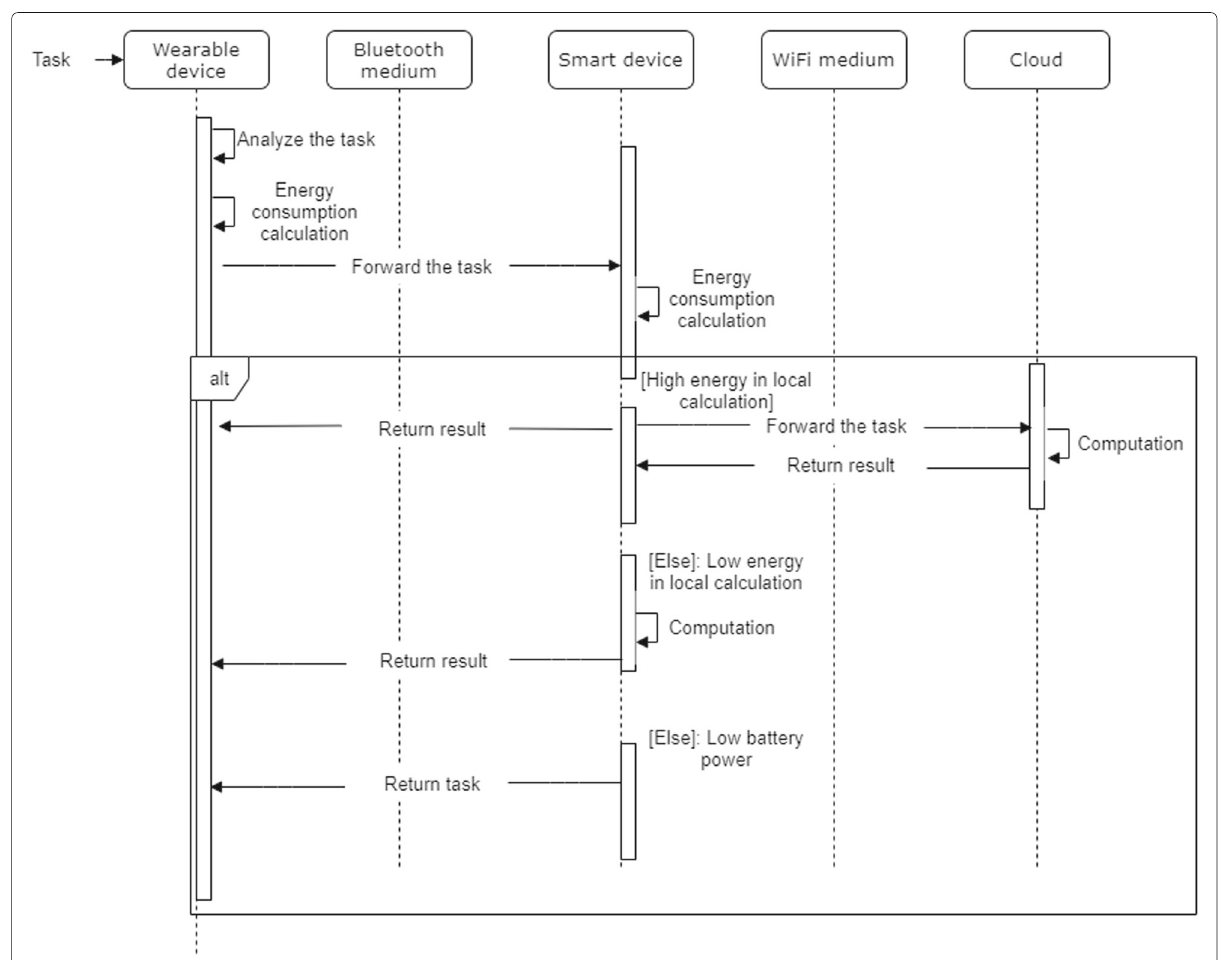
Fig. 2 Sequential diagram of offloading process